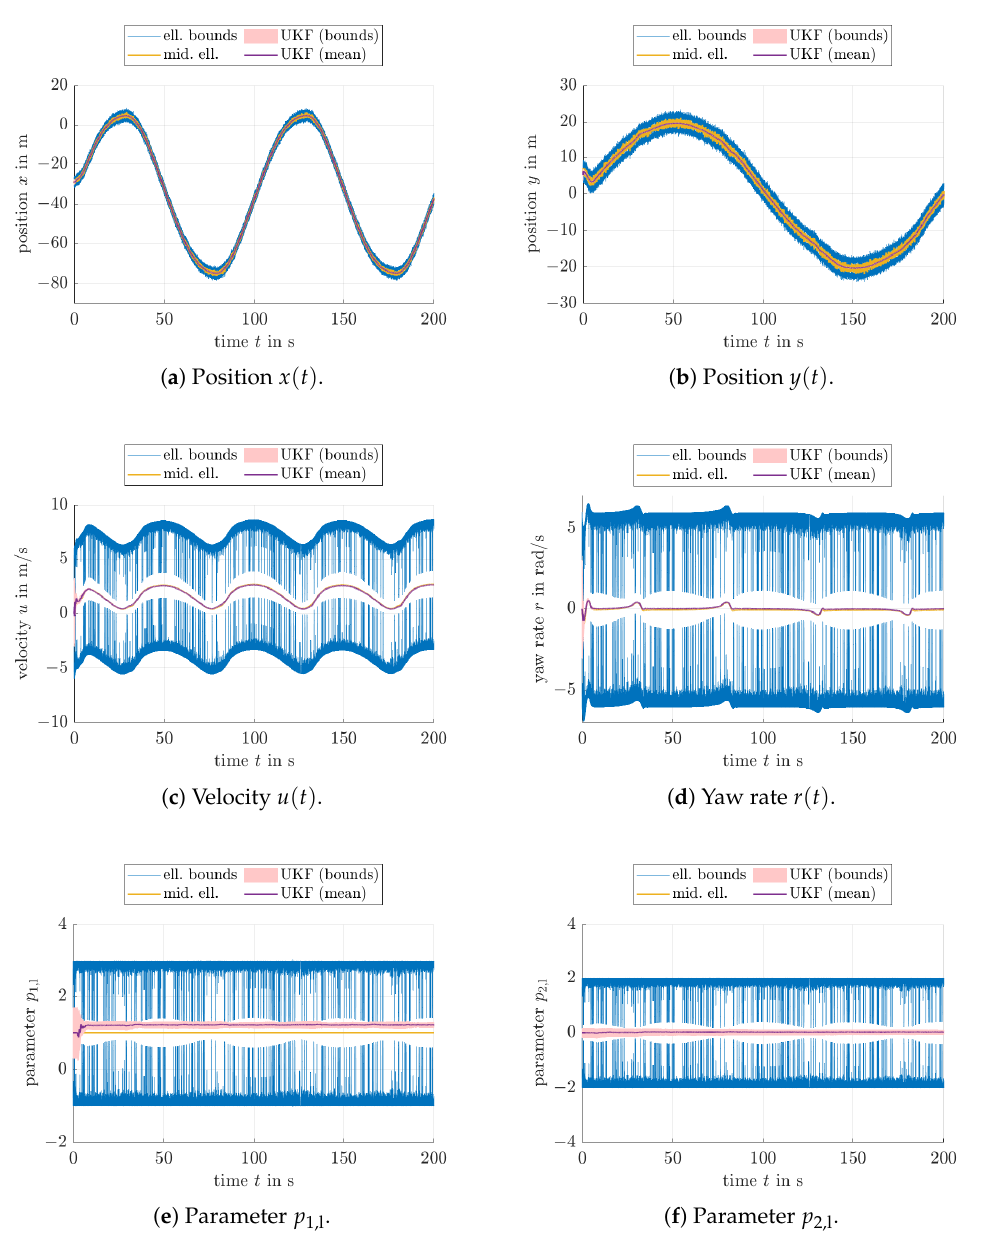
Figure 4. Estimation results with adaptation of the bounds for the uncertain system parameters: Scaling factor r = 1 for the state prediction (0.02% confidence bound for n = 10) with 99% confidence bounds of process and measurement